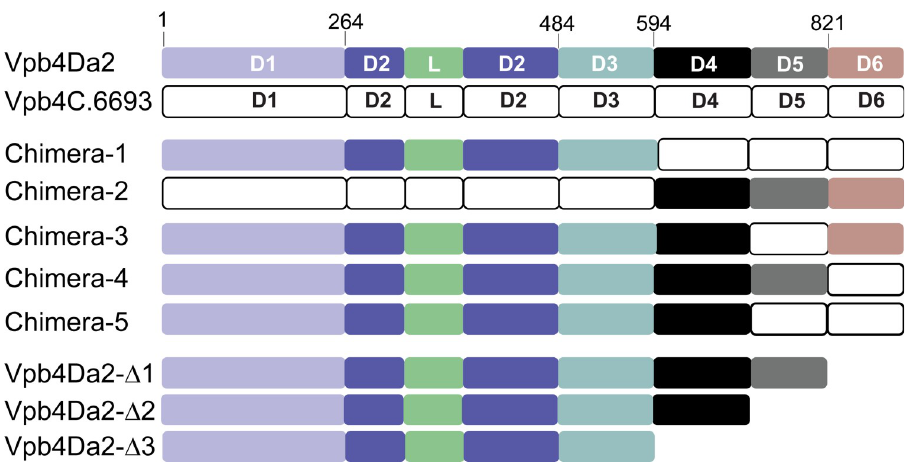
Fig 5. Schematic representation of Vpb4Da2 and Vpb4C.6693 domain-swap and truncation variants. Domains and putative pore-forming loop (L) are labeled and color coded.